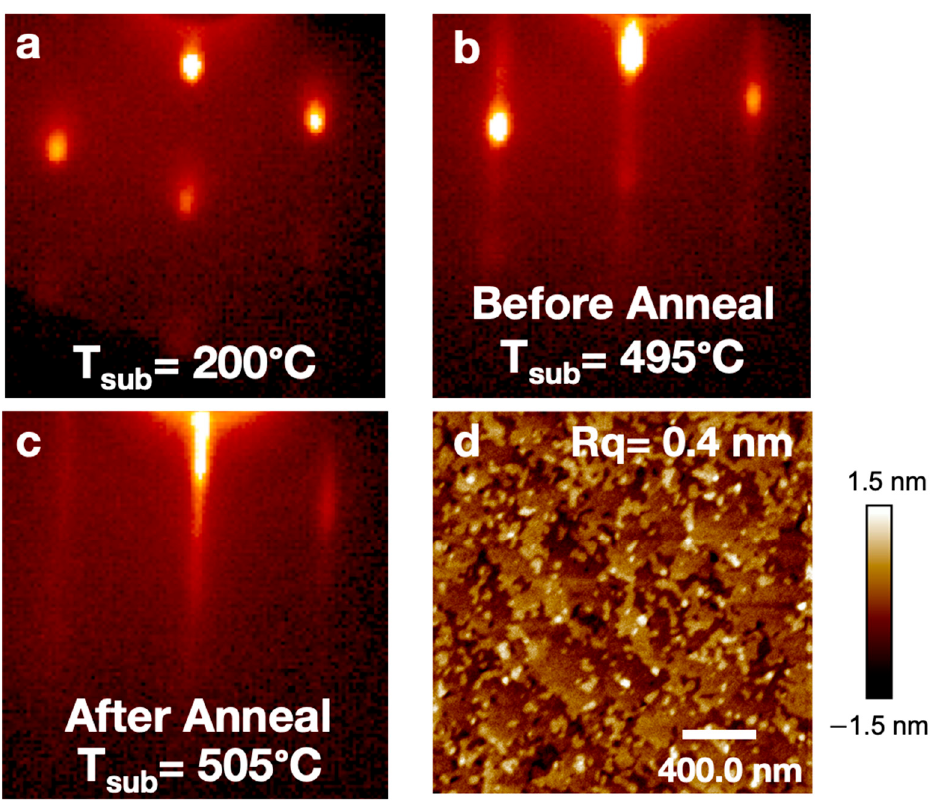
Figure 1. Reflection high-energy electron diffraction (RHEED) images of the InP(111)B surface ( a ) at T sub = 200 °C, ( b ) at T sub = 495 °C before anneal, and ( c ) at T sub = 505 °C after 5 min anneal, i.e., the deoxidized surface with the newly formed In 2 Se 3 layer via Se passivation of InP(111)B substrate. RHEED patterns are obtained along [011] direction of the substrate. ( d ) Atomic force microscopy (AFM) image of the sample shown in ( c ) with smooth atomically flat In 2 Se 3 layer which has a rot mean square roughness of Rq = 0.4 nm.